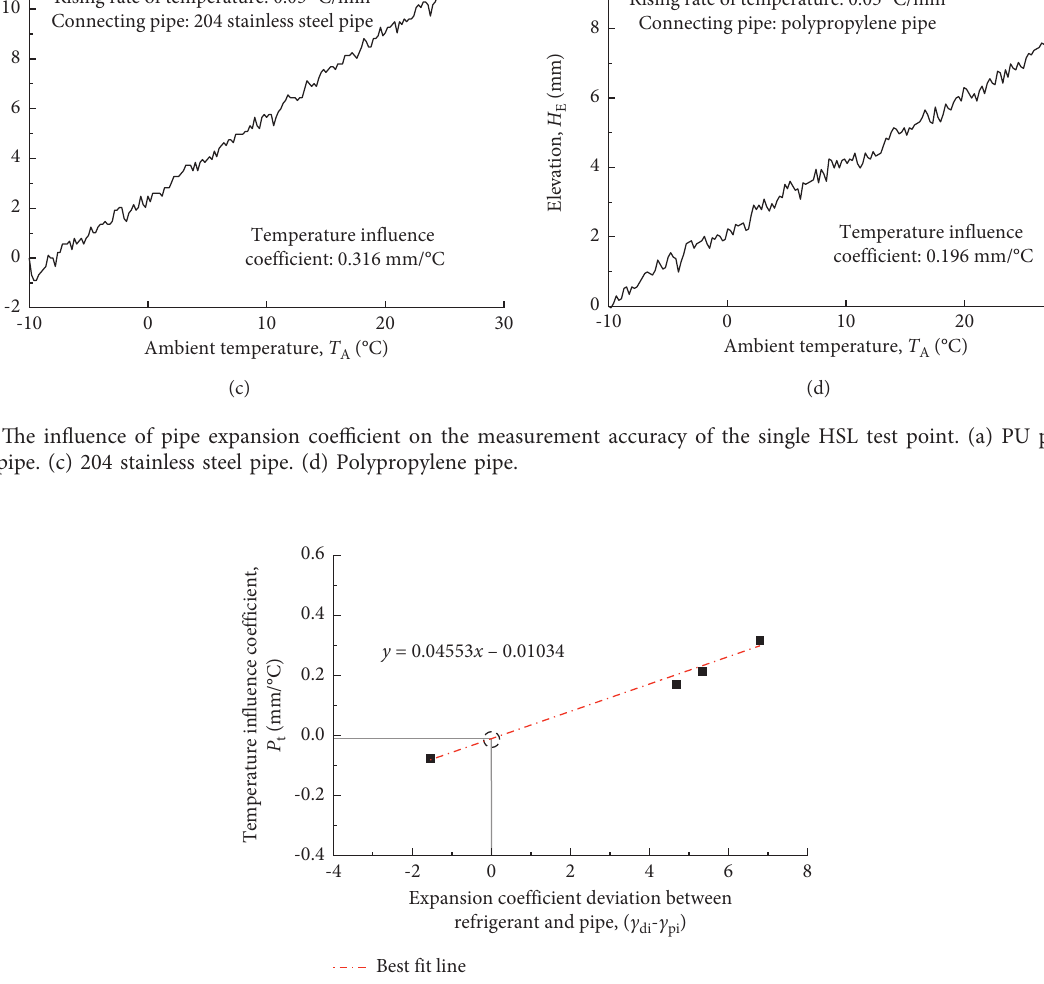
Figure 6: The relationship between the temperature influence coefficient and the expansion coefficient deviation between the refrigerant and pipe.